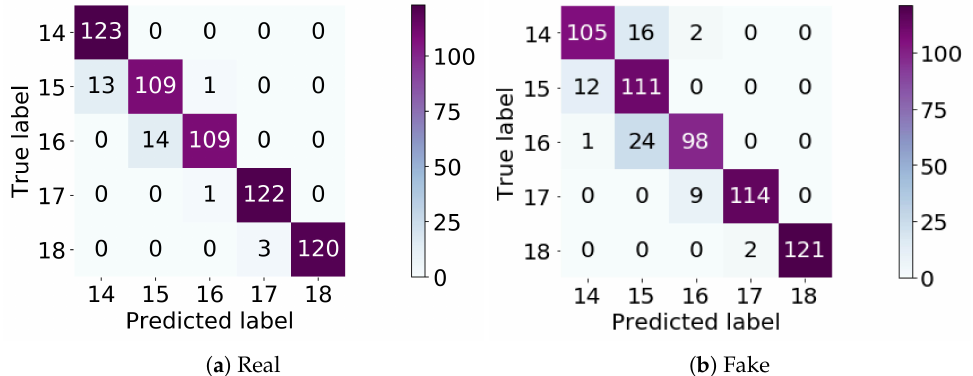
Figure 10. The classification results by the level classifier. ( a ) The confusion matrix of classification on the real data; ( b ) the confusion matrix of classification on the fake data.